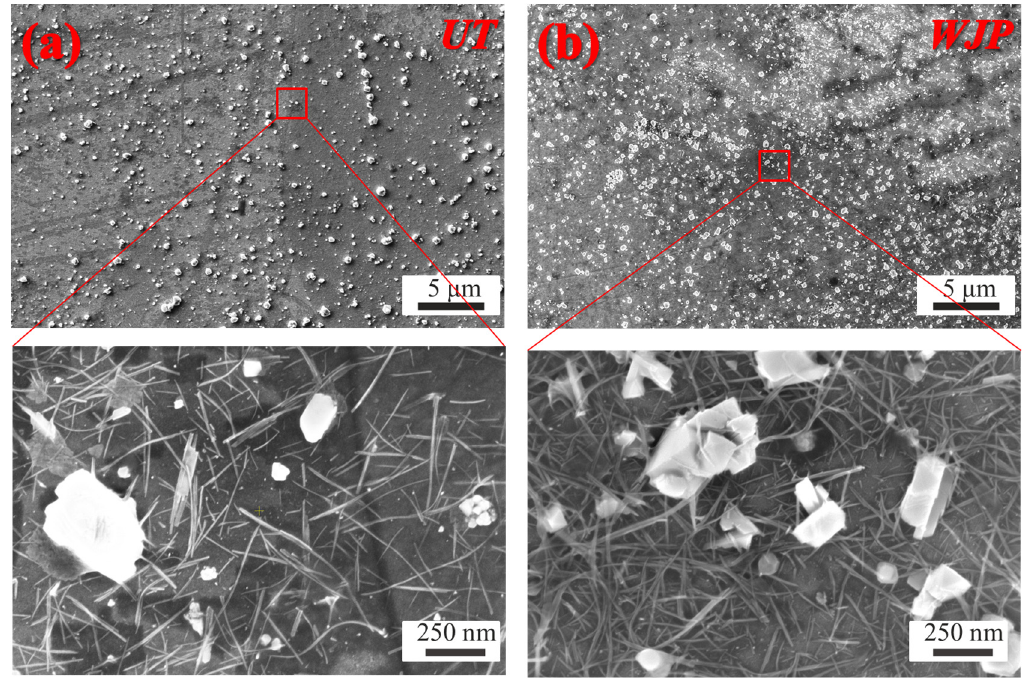
Figure 2. Surface morphology of 600 MA after the short-period exposure experiment. ( a ) UT, ( b ) WJP.